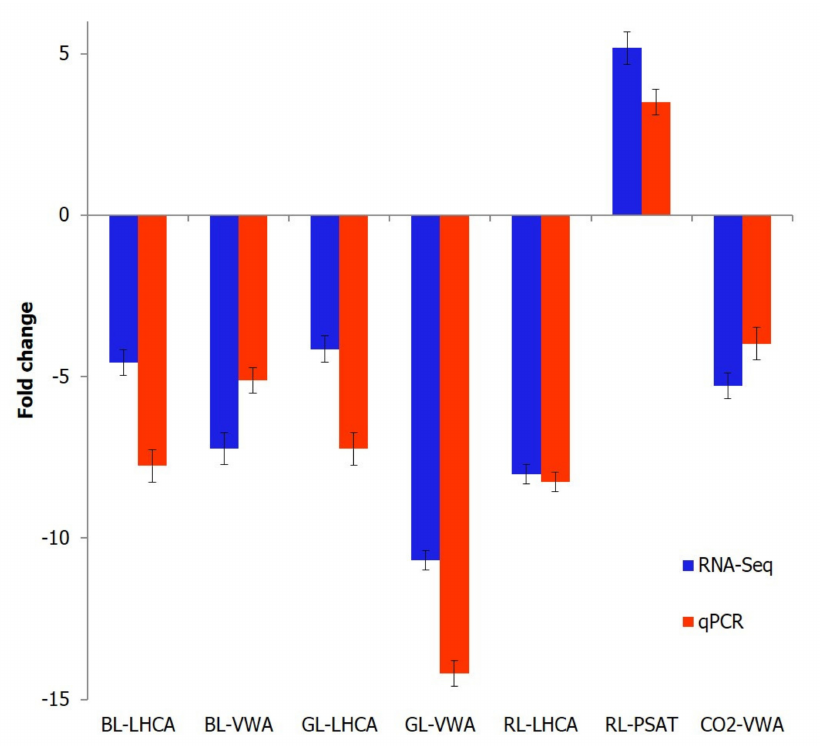
Figure 4. A comparison of differential gene expressions in Kappaphycus alvarezii by RNA-Seq and real-time PCR. LHCA, light-harvesting complexes; VWA, Von Willebrand factor type A; PSAT, phosphoserine aminotransferase; BL, blue light; GL, green light; RL, red light. A comparison of different light wavelengths against WL revealed the largest num- ber of DEGs in BL-treated samples, with five upregulated and 28 downregulated DEGs (Figure 5). In the CO 2 enrichment experiment, a total of 138 transcripts were found dif- ferentially expressed, with 74 upregulated and 64 downregulated transcripts (Table 4). Overall, the highest number of DEGs were detected between WL and the composite of BL+GL+RL and the highest number of significantly up/downregulated genes encoded ribosomal proteins, indicating a high turnover rate of protein synthesis. Furthermore, a majority (578/582) of the transcripts were found downregulated, implying that these may be associated with differential intensities of the composite and individual wavelengths.